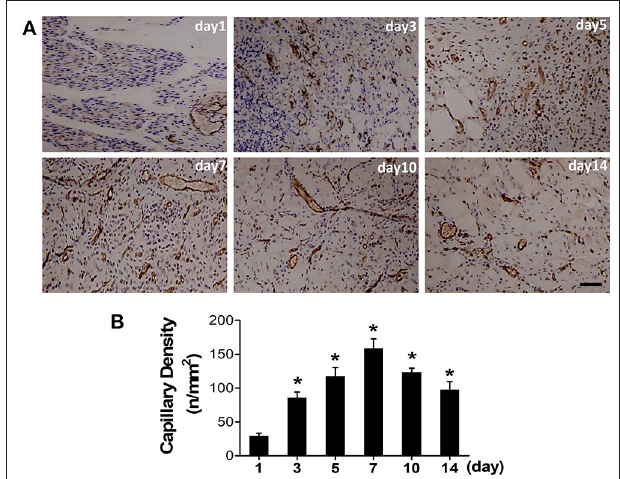
FIGURE 5 | Angiogenesis progression after the induction of ischemia. (A) Representative photographs of CD31 positive vessel were immunohistochemically detected at a serial of time points after surgery. (B) Quantitative analysis of CD31 capillary density in each group ( * P < 0.05, vs. day 1).